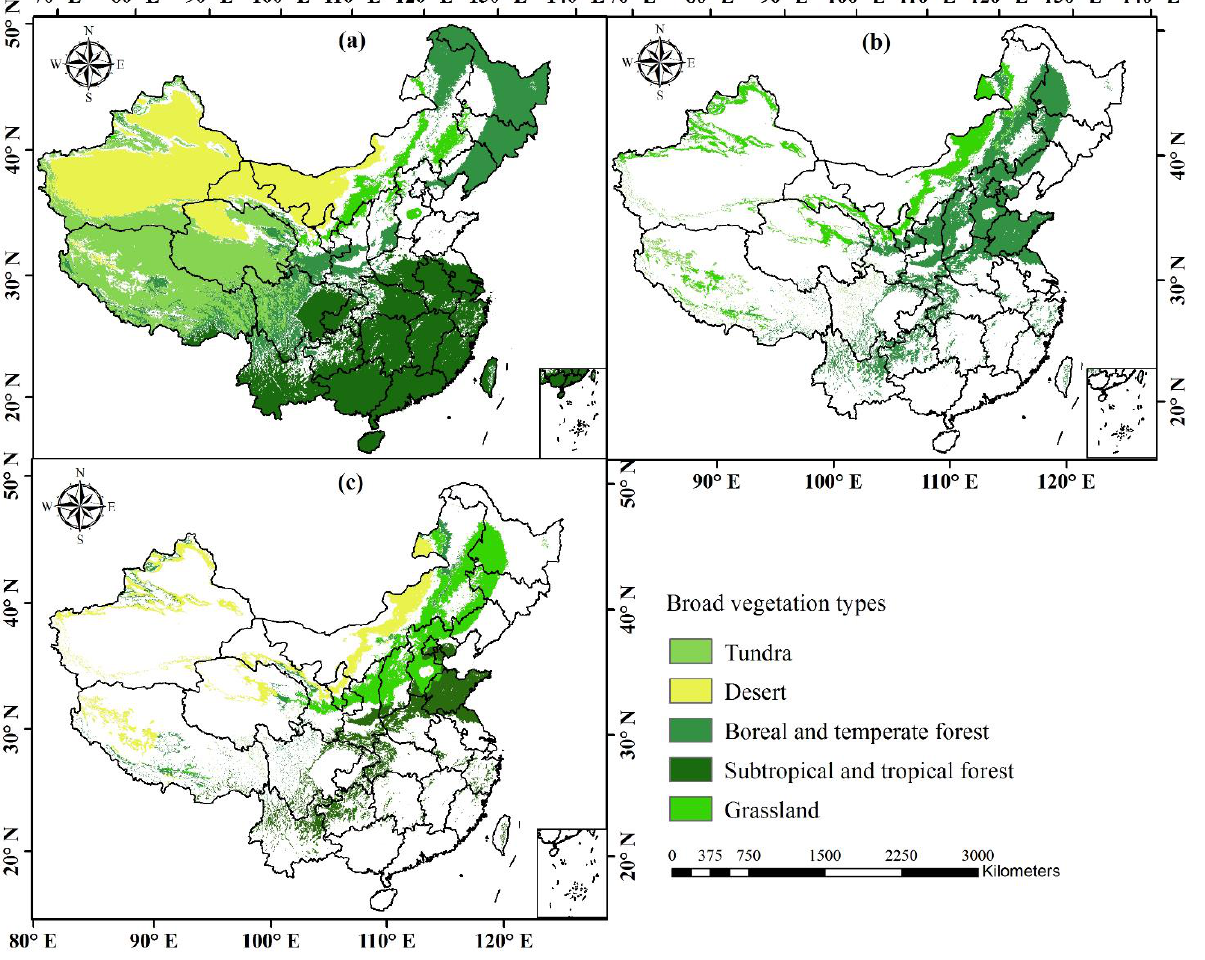
Figure 8. Comparisons of the vegetation maps of China based on CSCS model with HLZ in the baseline scenario. The areas of consistent class ( a ), the inconsistent regions for classes based on CSCS model ( b ), and the inconsistent pixels for each class based on HLZ model ( c ).